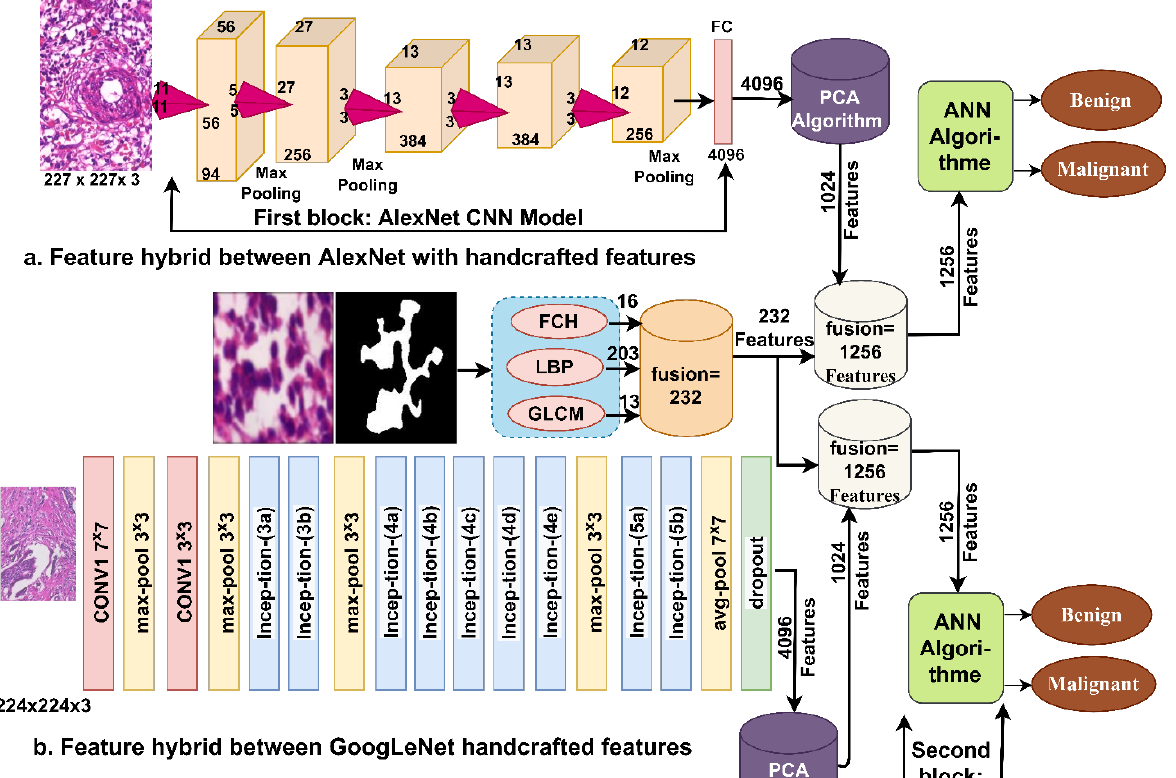
Figure 4. An architecture for diagnosing BC by ANN based on fusion features.